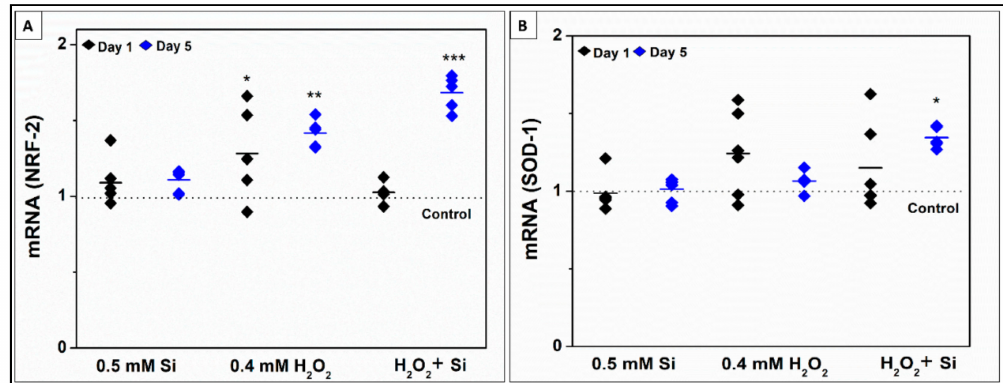
Figure 9. Si ions enhance antioxidant marker expression in the presence of toxic oxidative stress. ( A ) Relative concentration of NRF-2 mRNA expressed by C2C12 skeletal muscle cells differentiated in media containing 0.5 mM silicon ions only, 0.4 mM H 2 O 2 only, and media containing 0.5 mM Si Ions + 0.4 mM H 2 O 2 for 1 and 5 days. NRF-2 expression was significantly upregulated in the 0.4 mM H 2 O 2 group at days 1 (1.28, p = 0.03) and 5 (1.41, p = 0.008) compared to the control, and in the H 2 O 2 + Si group at day 5 (1.7, p = 0.00002). ( B ) Relative concentration of SOD-1 mRNA expressed by C2C12 skeletal muscle cells differentiated in media containing 0.5 mM silicon ions only, 0.4 mM H 2 O 2 only, and media containing 0.5 mM Si Ions + 0.4 mM H 2 O 2 for 1 and 5 days. SOD-1 expression was significantly upregulated in the H 2 O 2 + Si group compared to the control at day 5 (1.35, p = 0.04), (* p < 0.05, ** p < 0.01, *** p < 0.001) and no other significant differences were